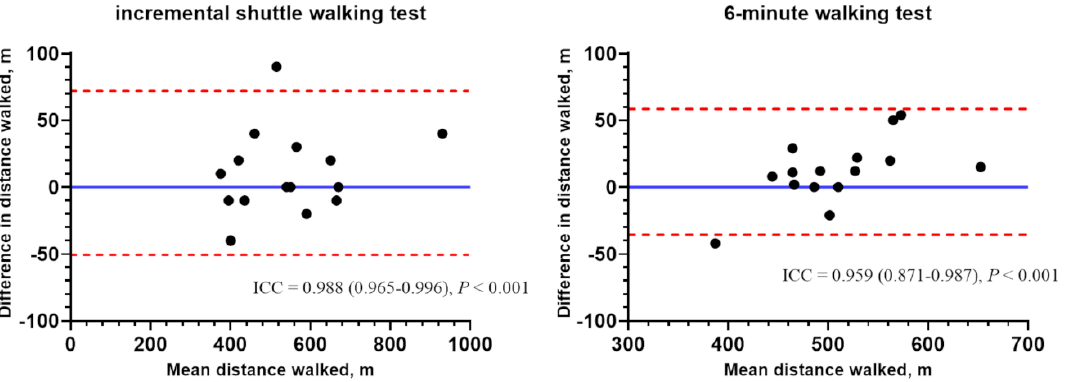
Figure 3. Bland–Altman plots representing reliability between the first and second tests of incre- mental shuttle walking test and 6 min walking test in Ulsan University Hospital. ICC was used to evaluate reliability. Abbreviation: ICC, intraclass correlation coefficients.